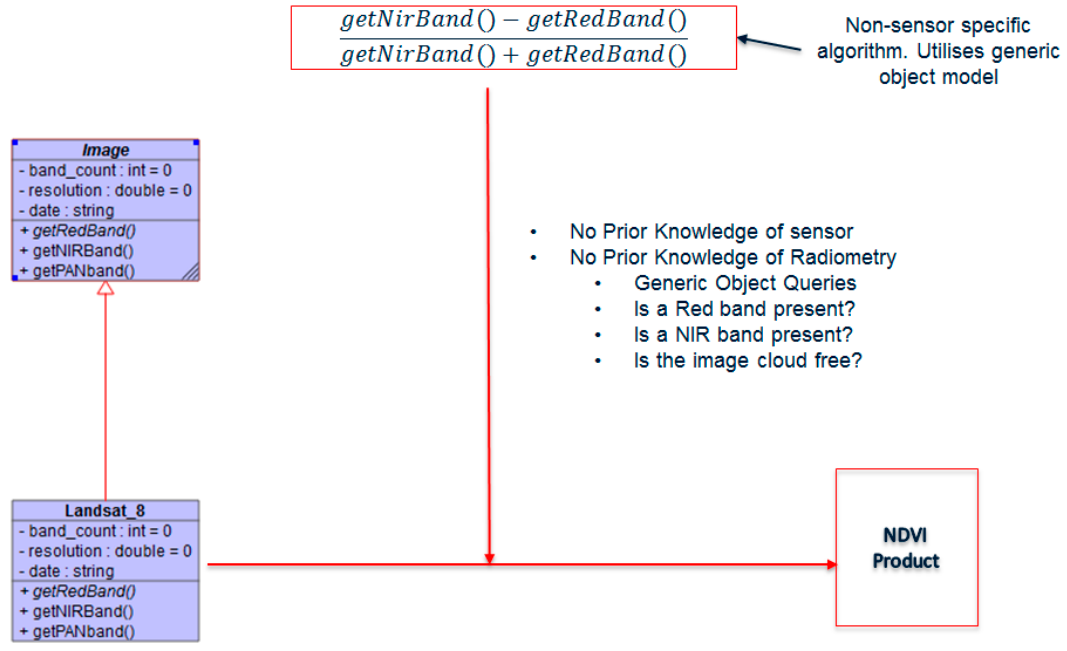
Figure 3. Image object model created at ingest.